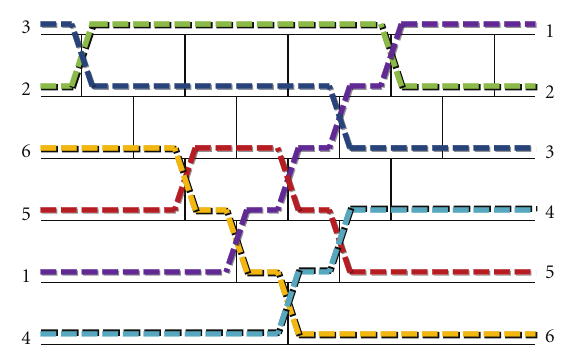
Figure 2: Parallel sorting network of size